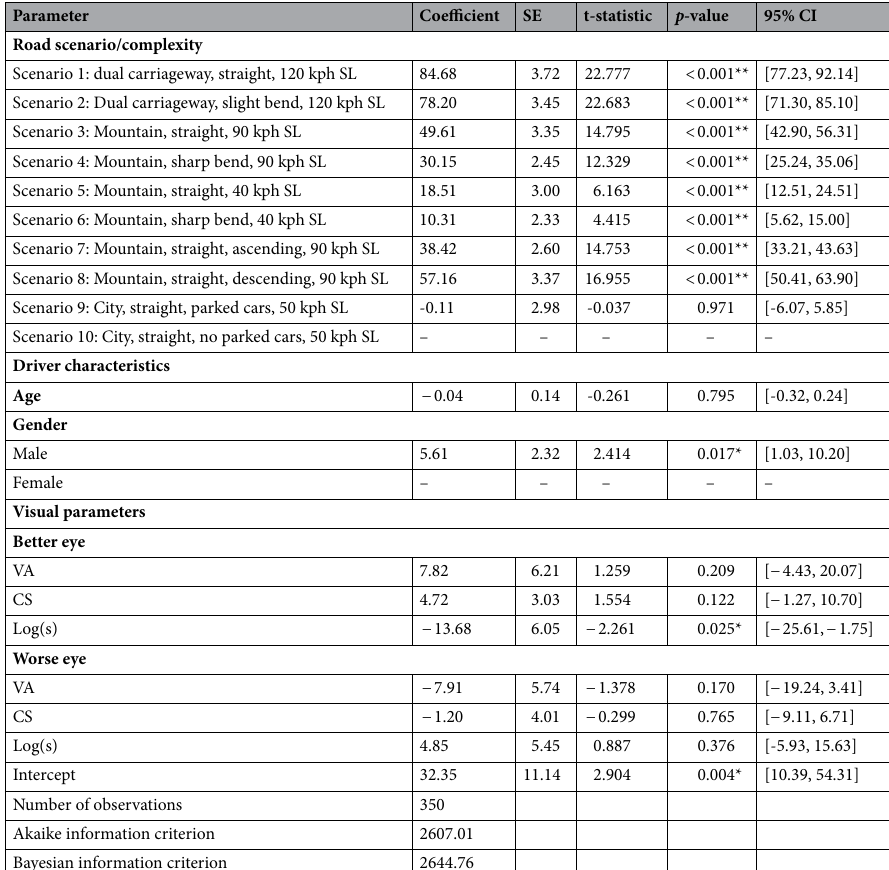
Table 5. Generalized linear mixed model (GLMM) estimates of speed self-regulation. Reference category (-); * p < 0.05; ** p <